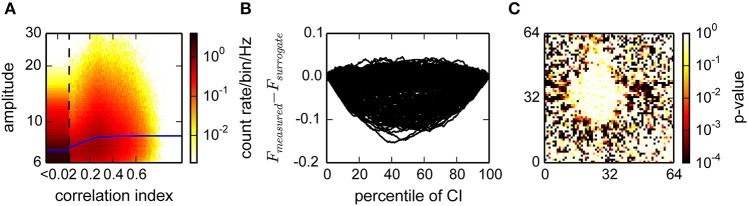
Estimation of the fraction of uncorrelated events in a recording from cultured neurons. (A) Histogram of the joint distribution of amplitudes, expressed as multiples of the variability estimate v, and correlation indices. The first bin (CI < 0.02) was rescaled by 1/20 and widened accordingly. Blue lines represent a sliding median of the amplitudes. (B) Difference between the distributions of measured and surrogate events. The graph shows the Kolmogorov Smirnoff test statistic for a random subset of electrodes from the data in (A). Negative values indicate a larger fraction of surrogate events with a lower correlation index. Events with a correlation index higher than the argument of the minimum of those curves are classified as correlated. (C)
p-values for deviation from identical distributions computed as illustrated in (B), for all channels. Red colors indicate that a channel is highly unlikely to be reporting noise.